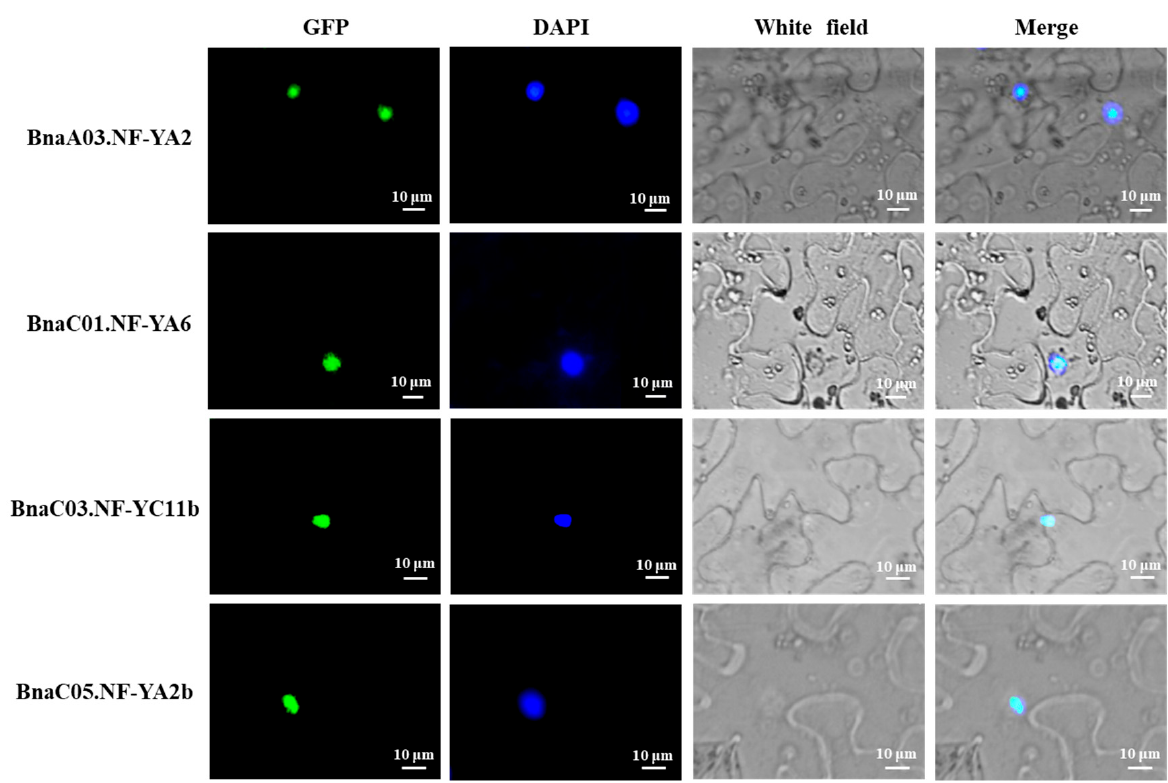
Figure 10. Subcellular localization of BnaA03.NF-YA2 , BnaC01.NF-YA6 , BnaC03.NF-YC11b and BnaC05.NF-YA2b. 35S::BnaNF-Ys-GFP constructs were introduced into tobacco. The blue color shows nuclei by DAPI staining. The GFP and DAPI fluorescence was observed with a fluorescence microscope. The images were taken in the dark and white field.